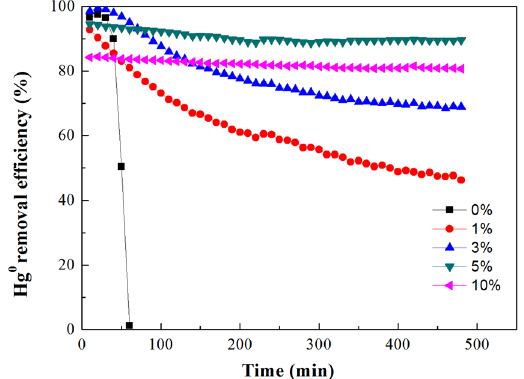
Figure 1. Efficiencies of Hg 0 removal over Fe 3 O 4 –NH 2 –Pd sorbent with different contents of Pd at 200